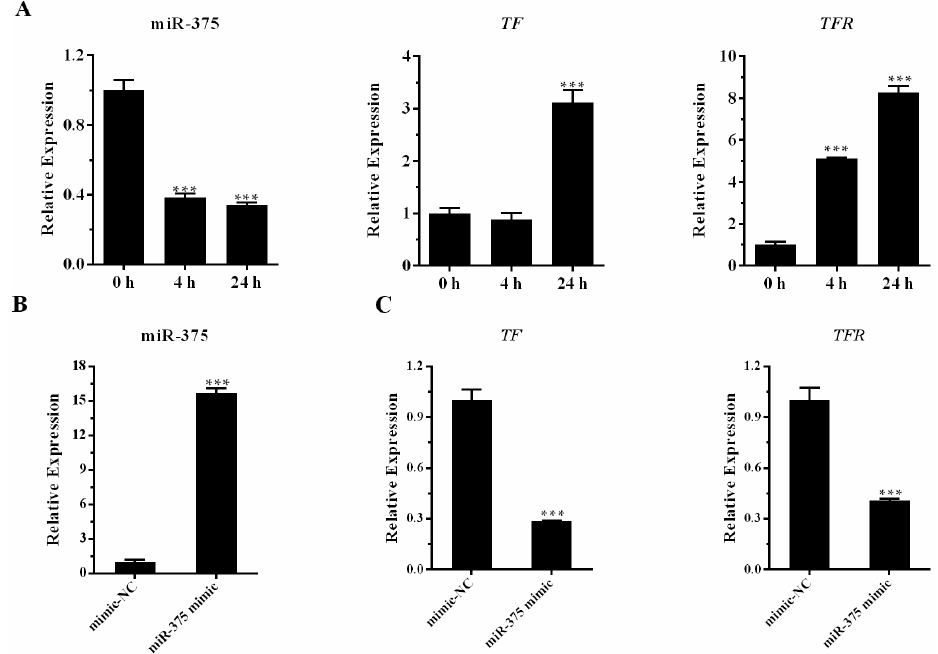
Figure 8. Expression analysis of miR-375, TF and TFR . ( A ) Relative expression of miR-375, TF and TFR in the three libraries; ( B ) Transfection efficiency of miR-375 mimic was detected by qRT-PCR. Values were described as mean ± SD ( n = 3, *** p < 0.001); ( C ) TF and TFR mRNA expressions were detected by qRT-PCR. Values were described as mean ± SD ( n = 3, *** p < 0.001).